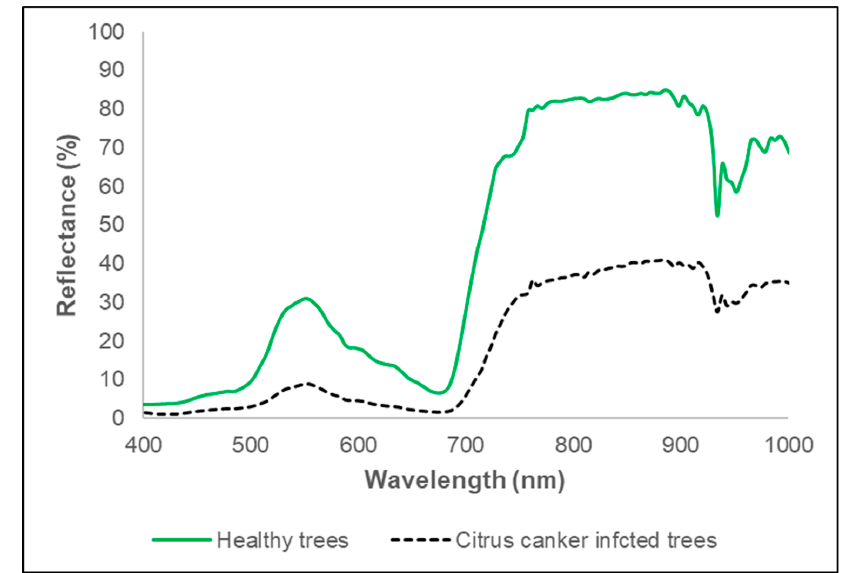
Figure 8. Measurement of the spectral reflectance of healthy citrus trees and trees infected with canker disease. Hyperspectral signatures of healthy trees and canker-infected trees were generated by the UAV-based imaging technique